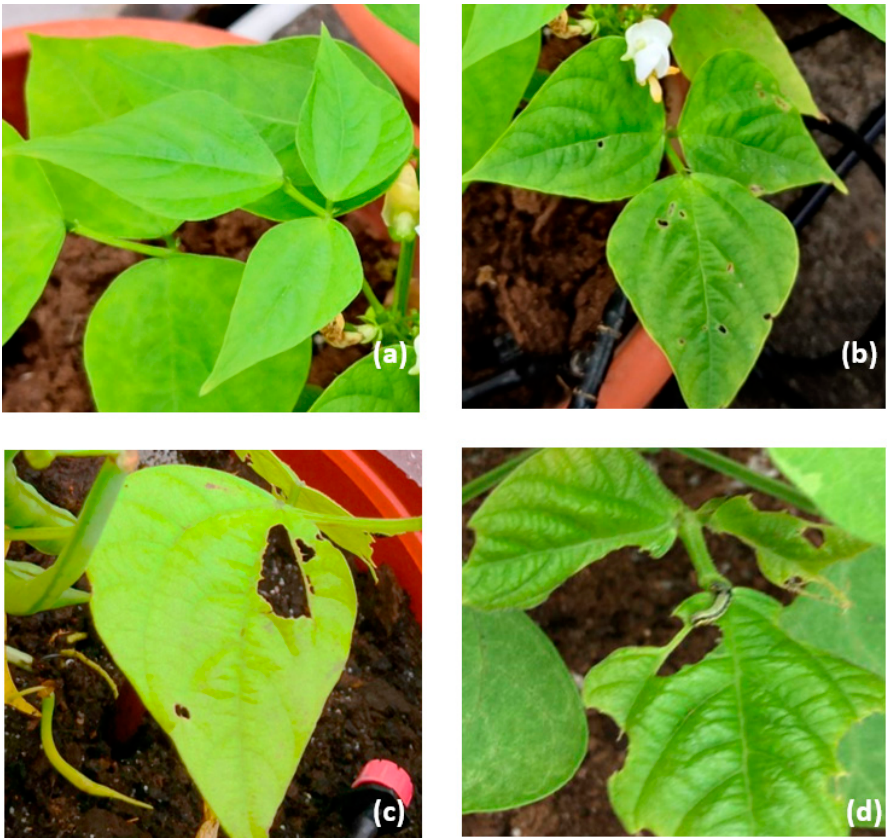
Figure 1. Insect injury index for bush bean. ( a ) No injury; ( b ) less than 5% insect injury; ( c ) 5% to 25% insect injury; and ( d ) greater than 25% insect injury. We also show in ( d ) a caterpillar eating the leaf. Atmosphere 2019 , 10 , x FOR PEER REVIEW